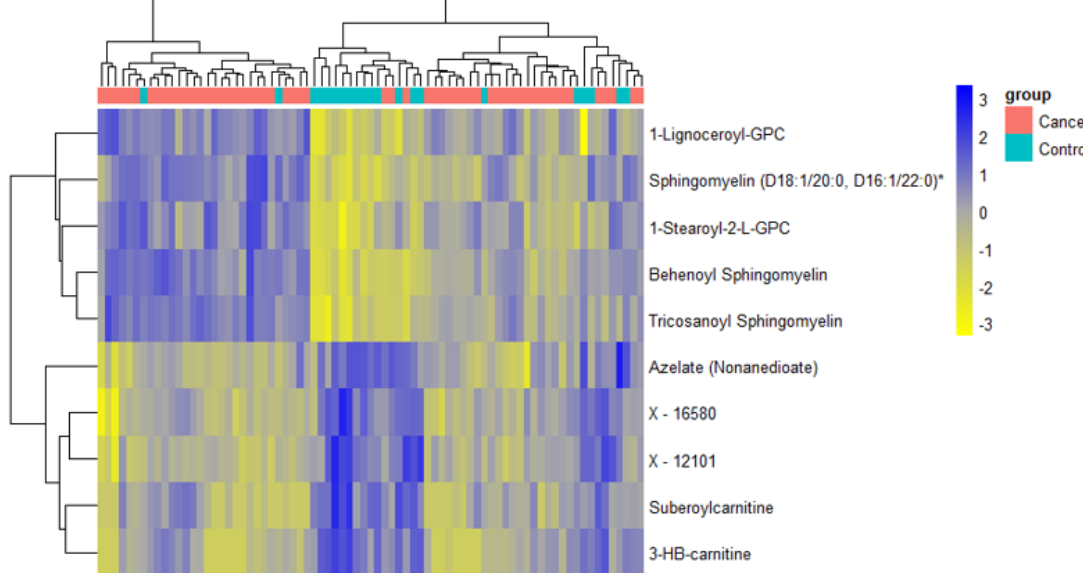
Figure 19. Hierarchical clustering using the top 10 discriminatory metabolites for the detection of endometrial cancer in post-menopausal women ( n = 77, cases = 56, controls = 21). Discriminatory metabolites were based on mean decrease accuracy metric using random forest analysis. The difference in intensities of the top 10 metabolites by cancer-control status is shown. Each coloured cell in the map represents the scaled concentration of indicated metabolite. Metabolites are clustered along the vertical axis while subjects are clustered along the horizontal axis. Metabolites starting with X are unnamed; the pathways of these are unknown.